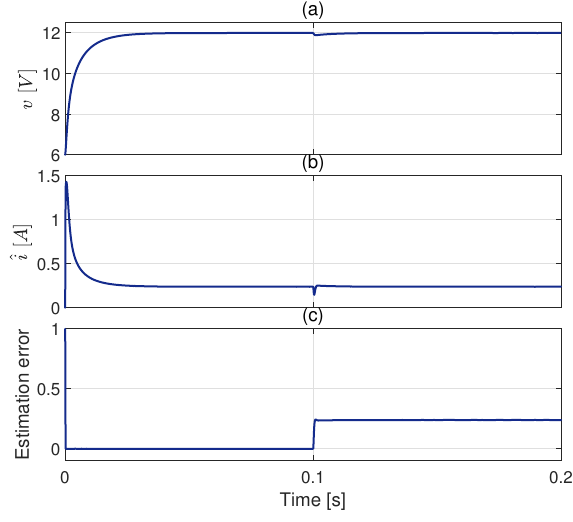
Figure 7. Response curves of boost converter with a step change in R . ( a ) Output voltage v , ( b ) estimated current ˆ i , ( c ) estimation